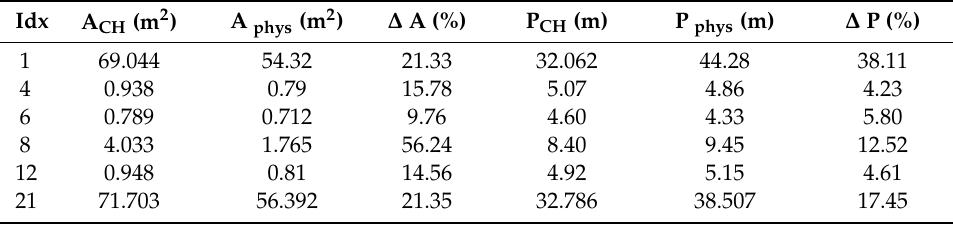
Table 10. Physical area and perimeter, difference in percent from convex hull (Z-axis).